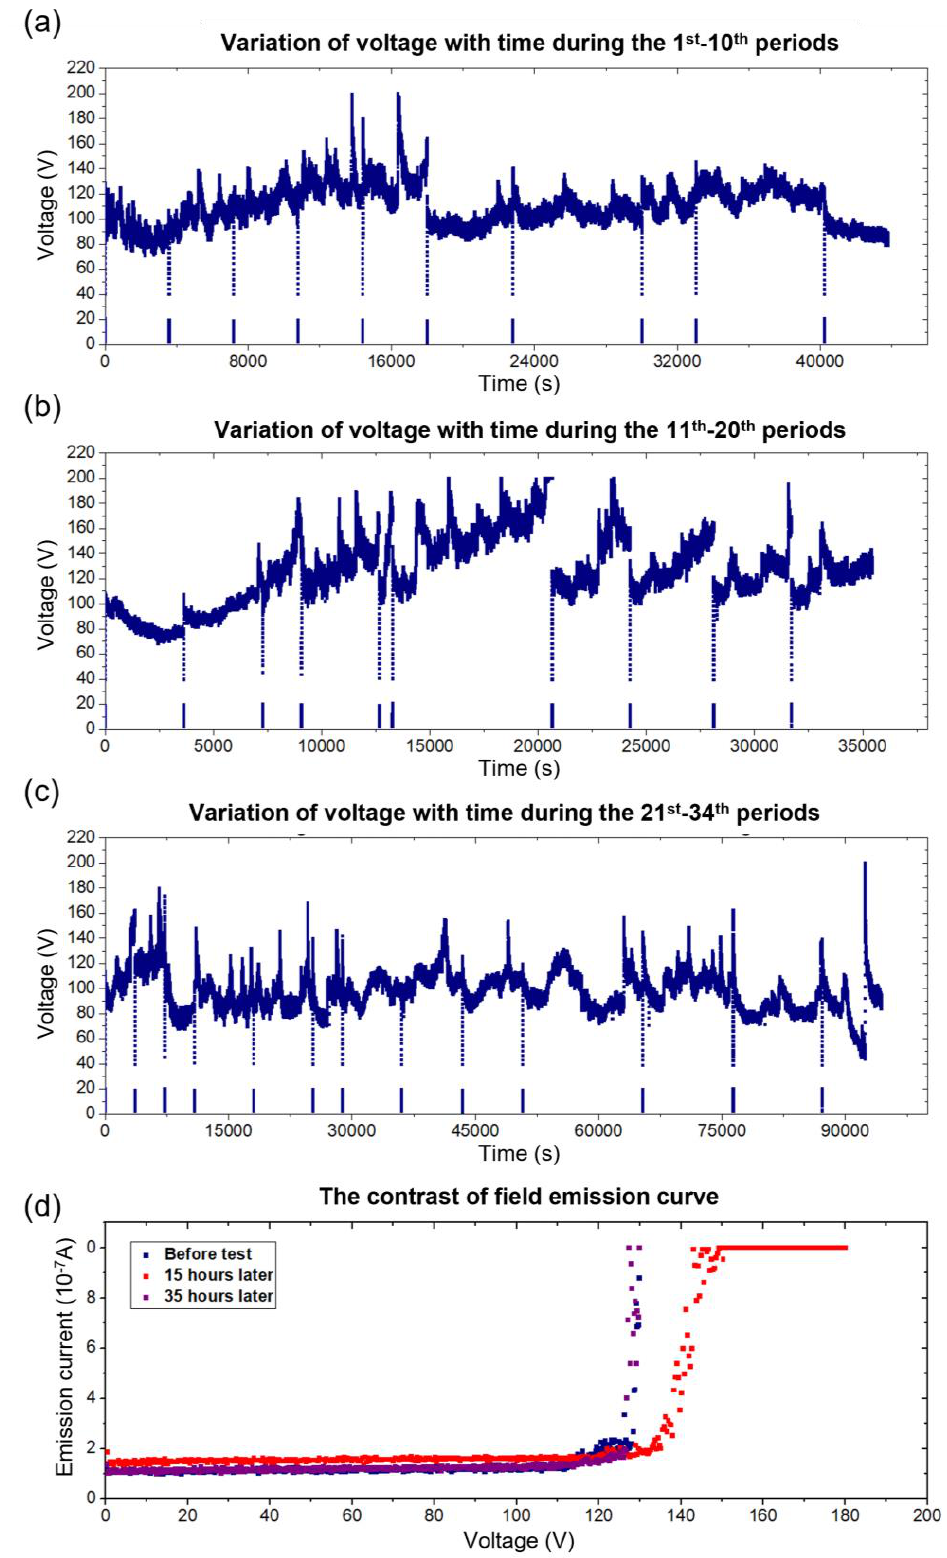
Figure 9. Variations in the working voltage and FE characteristics of our hybrid electron source during the test. ( a – c ) The time-dependent curve of working voltage during the 1st–10th periods, 11th–20th periods, and 21st–34th periods, respectively. ( d ) The contrast of the FE curve before, after 15 h, and after 35 h of the test.